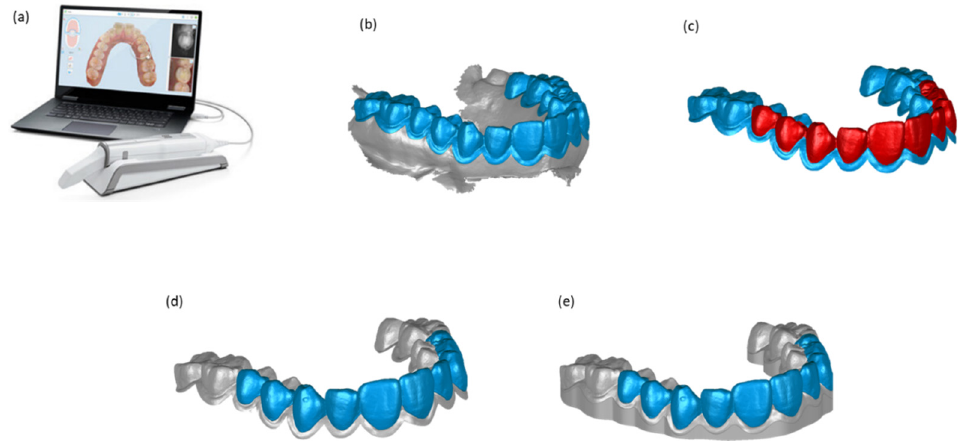
Figure 2. The five steps of the digital process for generating the reference model of a tray: 3D scan- ning ( a ), tray area selection ( b ), whitening area selection ( c ), offset creation for reservoirs ( d ), crea- tion of the final STL file ( e ).